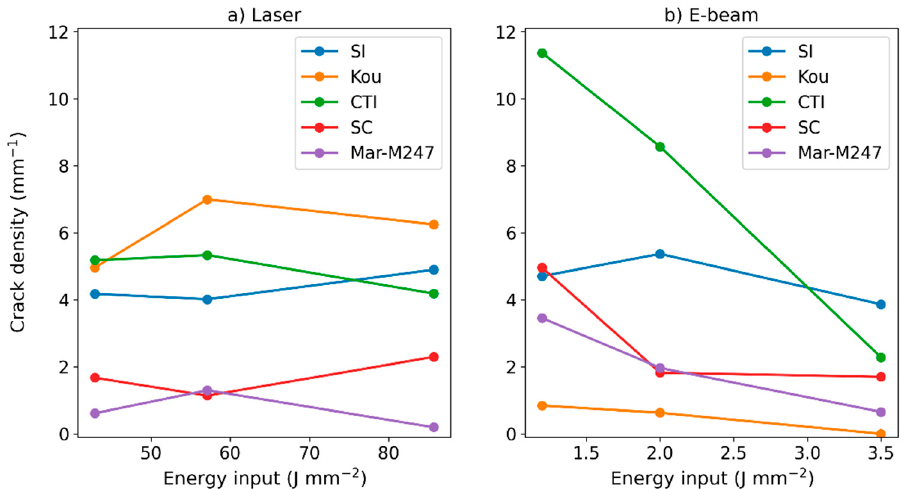
Figure 5. Crack density of experimental alloys and Mar-M247 from ( a ) laser and ( b ) electron beam melting experiments.